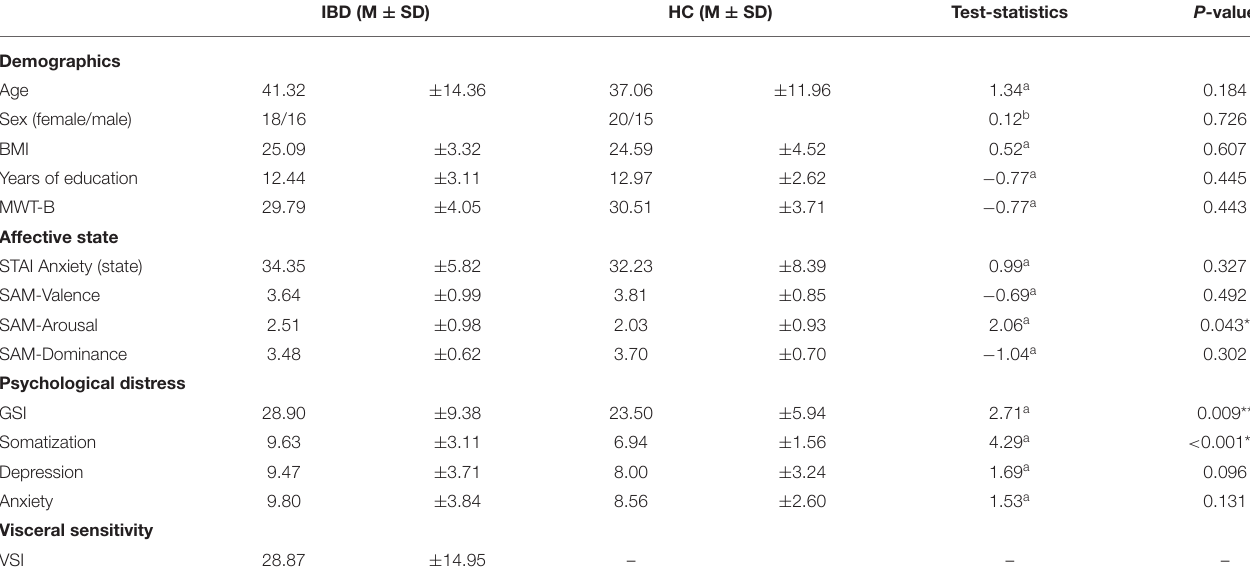
TABLE 1 | Sample characteristics including demographic data, affective state prior measurement and psychological